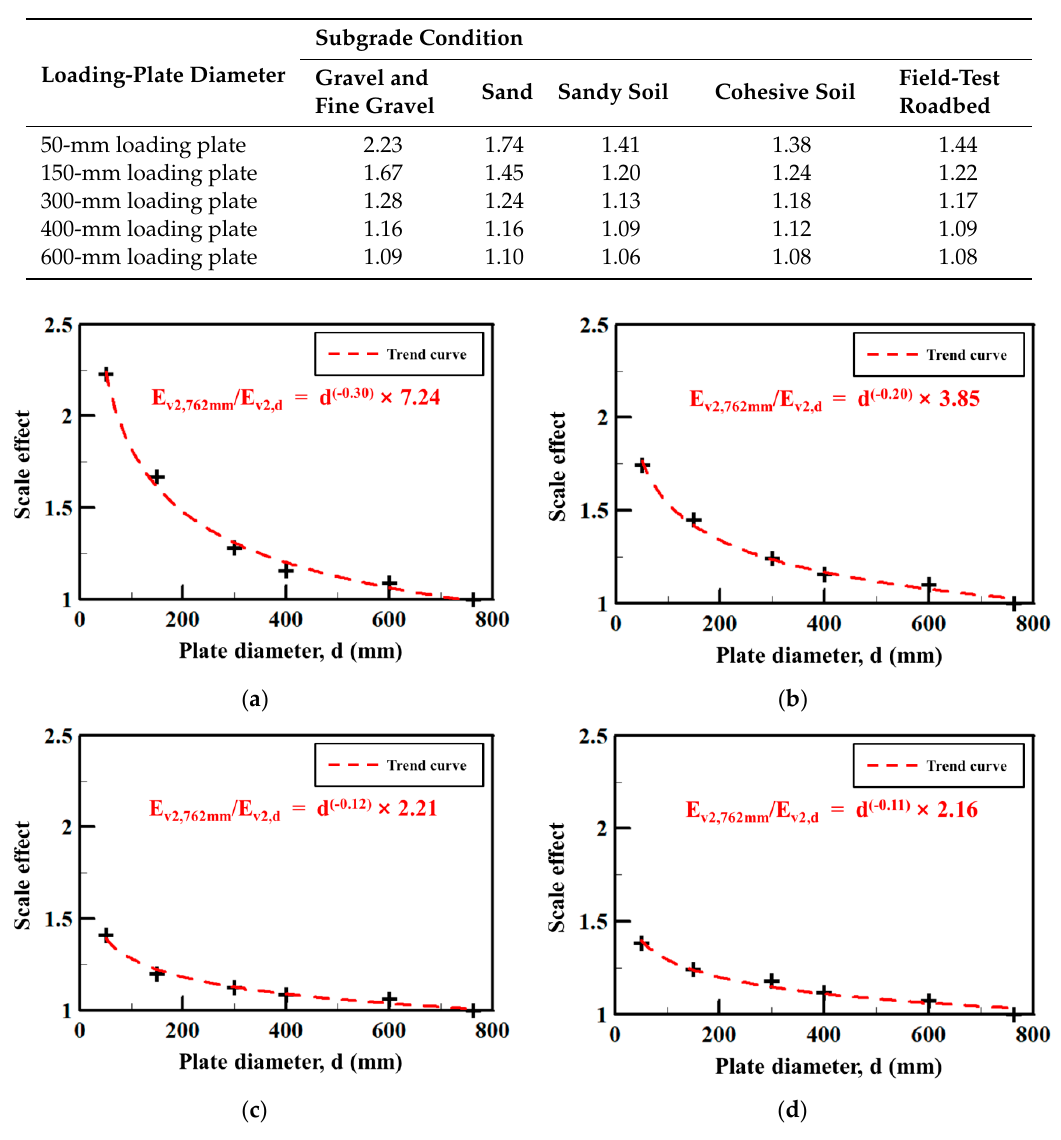
Figure 6. Regression analysis of the scale-effect results according to the subgrade condition: ( a ) gravel and fine gravel; ( b ) sand; ( c ) sandy soil; ( d ) cohesive soil.